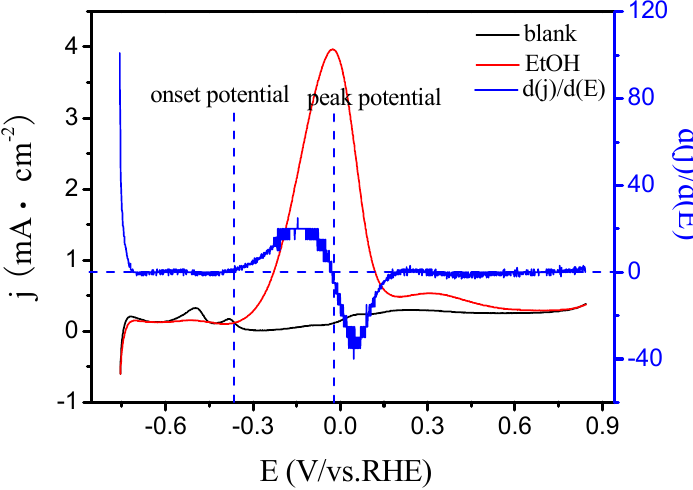
Figure 8. Linear sweep voltammetry of ethanol oxidation on a Pt electrode in 0.1 M KOH solution. Blue line: The current density of ethanol oxidation takes a derivative with respect to the potential.